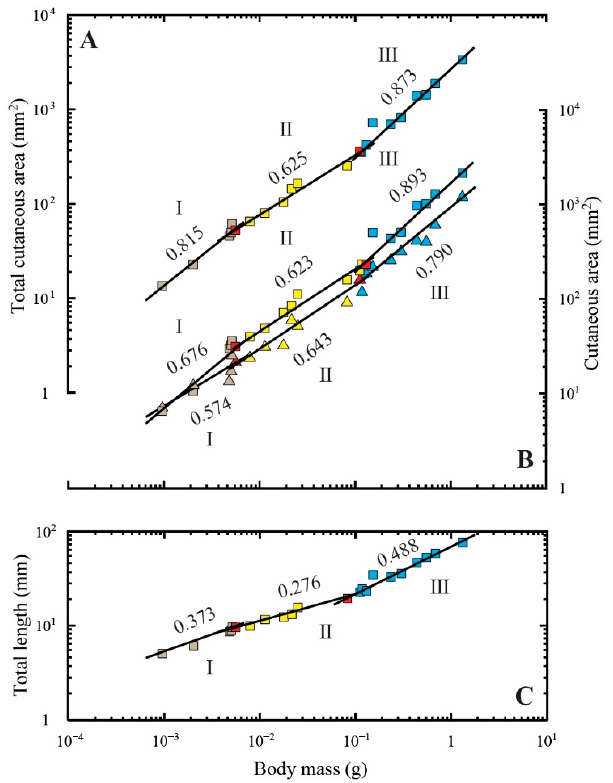
Figure 4. Allometric relationships between the body mass and total cutaneous area (colored squares) ( A ); body surface area (colored squares) ( B ); bilateral fin area (colored triangles) ( B ); total length (colored squares) ( C ). The values above the regression lines indicate their slopes. The ontogenetic phase shifts are presented in three colors (gray, phase I; yellow, phase II; blue, phase III). The red-colored spots indicate the measurements that overlap between phases I and II and between phases II and